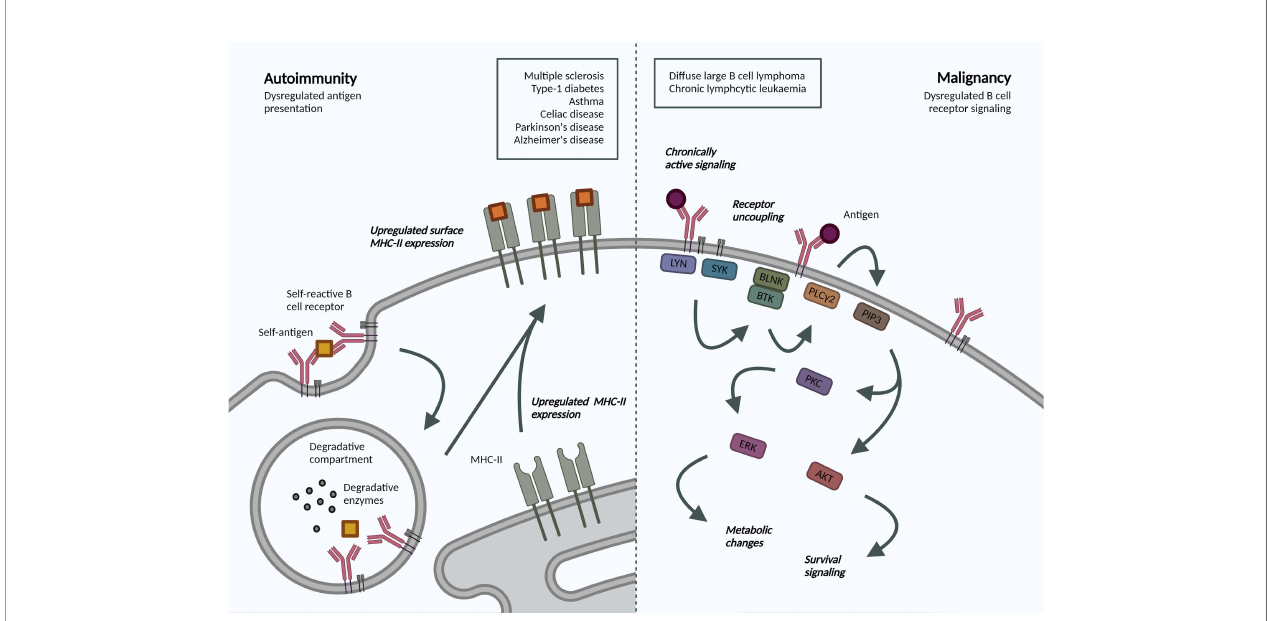
FIGURE 2 | Altered BCR-antigen endocytosis, traf fi cking and presentation in B cell autoimmunity and malignancy. Autoimmunity. BCR-mediated self-antigen uptake can increase presentation of relevant peptides and drive disease progression. B cells in many autoimmune disorders exhibit increased surface MHC-II expression, though the repertoire of presented peptides has not been addressed. Malignancy. Following antigen binding to the BCR, a signaling cascade is initiated through phosphorylation of Ig a / b ITAMs residues. Downstream activation of ERK and AKT mediates many metabolic changes and survival signaling, which are dysregulated in B cell malignancies due to localization and traf fi cking dynamics of the BCR. Created with